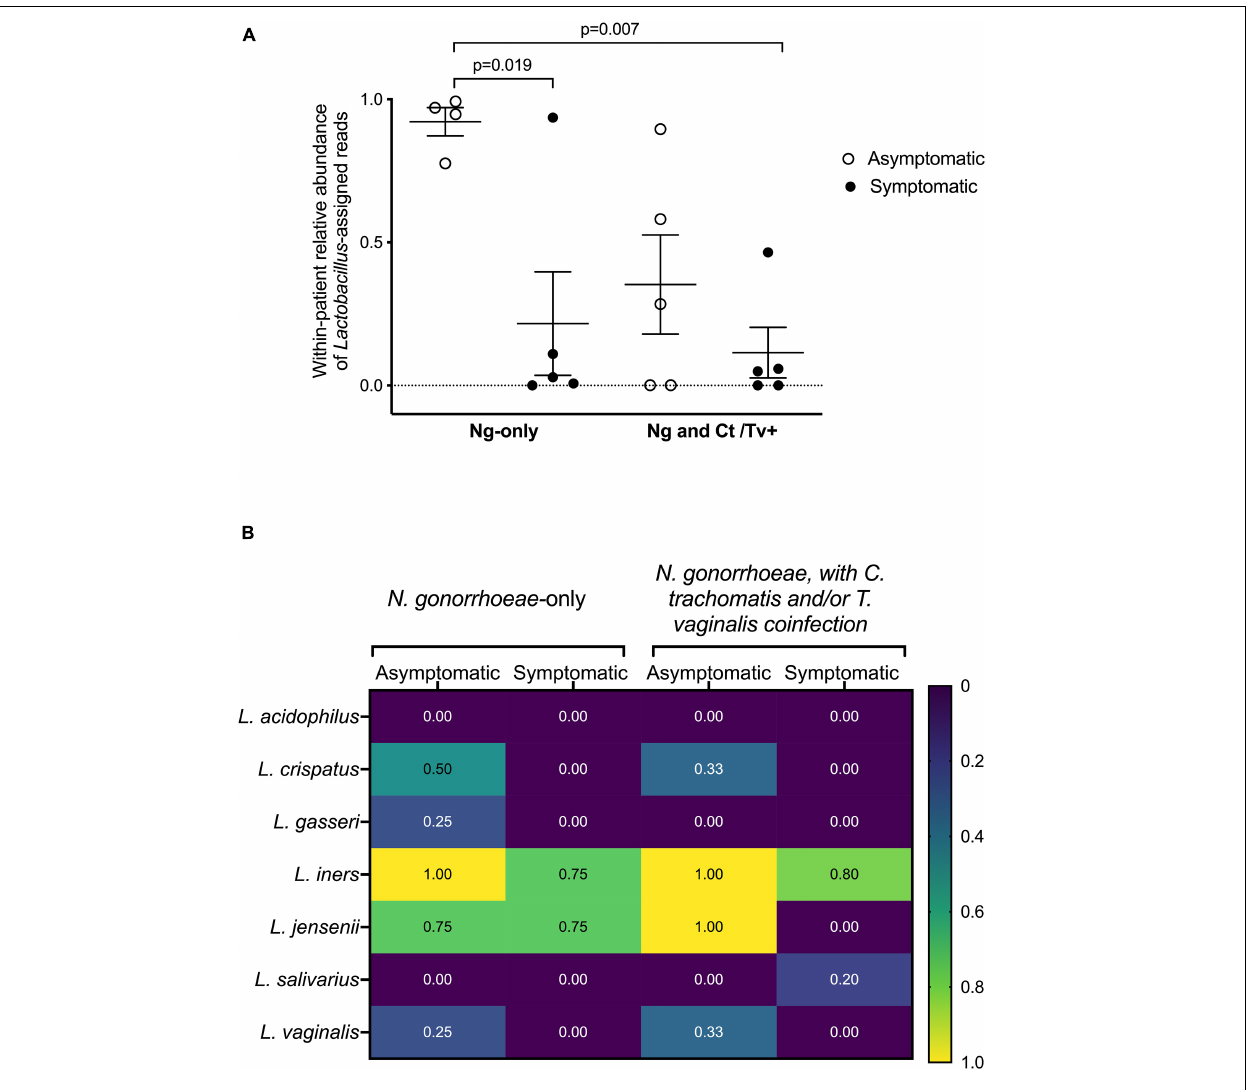
FIGURE 5 | Lactobacillus spp. detection with respect to clinical presentation and other STI co-infection. The fraction of reads assigned to Lactobacillus among all sequence reads comprising an individual’s microbial community is shown (A). Participants have been grouped by symptom and co-infection status. Statistically significant differences between patient groups were explored with one-way ANOVA with Tukey’s correction for multiple comparisons. The presence of specific Lactobacillus spp. was also assessed by the presence/absence of commercially available real-time PCR assay (B). Participants have been grouped by symptom and co-infection status. The fraction of individuals within each group positive for each of the seven Lactobacillus species in our panel ( L. acidophilus , L. crispatus, L. gasseri, L. iners , L. jensenii , L. salivarius , and L. vaginalis ) are shown as a heatmap, with values ranging from “0” (i.e., none of the women in the group positive for that species) to “1.0” (i.e., all women in the group positive for that